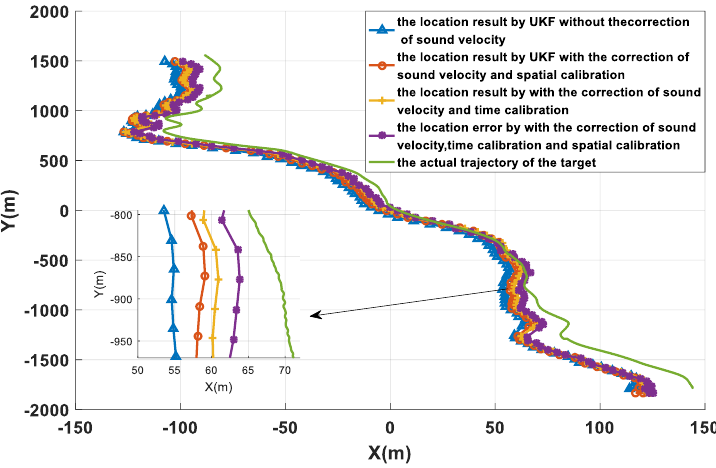
Figure 16. The relative delay result of the positioning signal after delay calibration ( a ) The relative de- lay of four positioning signal after delay calibration; ( b ) the relative delay of the 70th positioning cycle. Figures 17 and 18 and Table 3 show the positioning results and error analysis of the sea trial. In Figure 17, the solid green line is the AUV trajectory collected by DGPS. The corresponding methods for the other colored lines are the same as in Figure 11. Figure 18 is the horizontal error of different positioning cycles, and the calculation method (cid:113) − ˆ x − ˆ y ( x ) 2 + ( y ) 2 , where ( x ) is the estimated horizontal position, is err _ r k = k k k k k , y k and ( ˆ x k , ˆ y k ) is the true horizontal position of the modem. Table 3 shows the statistical results of the horizontal error. Methods 1 to 4 in the table correspond to the methods represented by the first four curves in the annotation box in the upper right corner of Figure 17. It can be seen from the data in the table that the algorithm (method 4) proposed in this paper reduces the positioning error and improves the horizontal positioning accuracy.